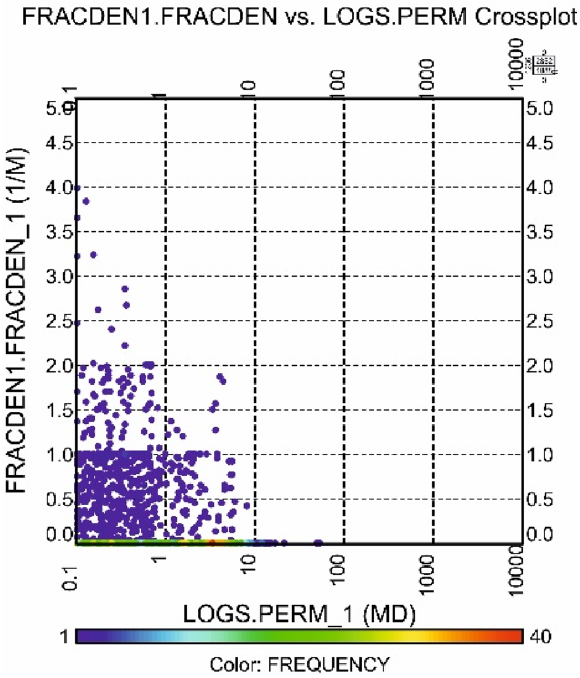
Fig. 12 Cross-plot of fracture density versus